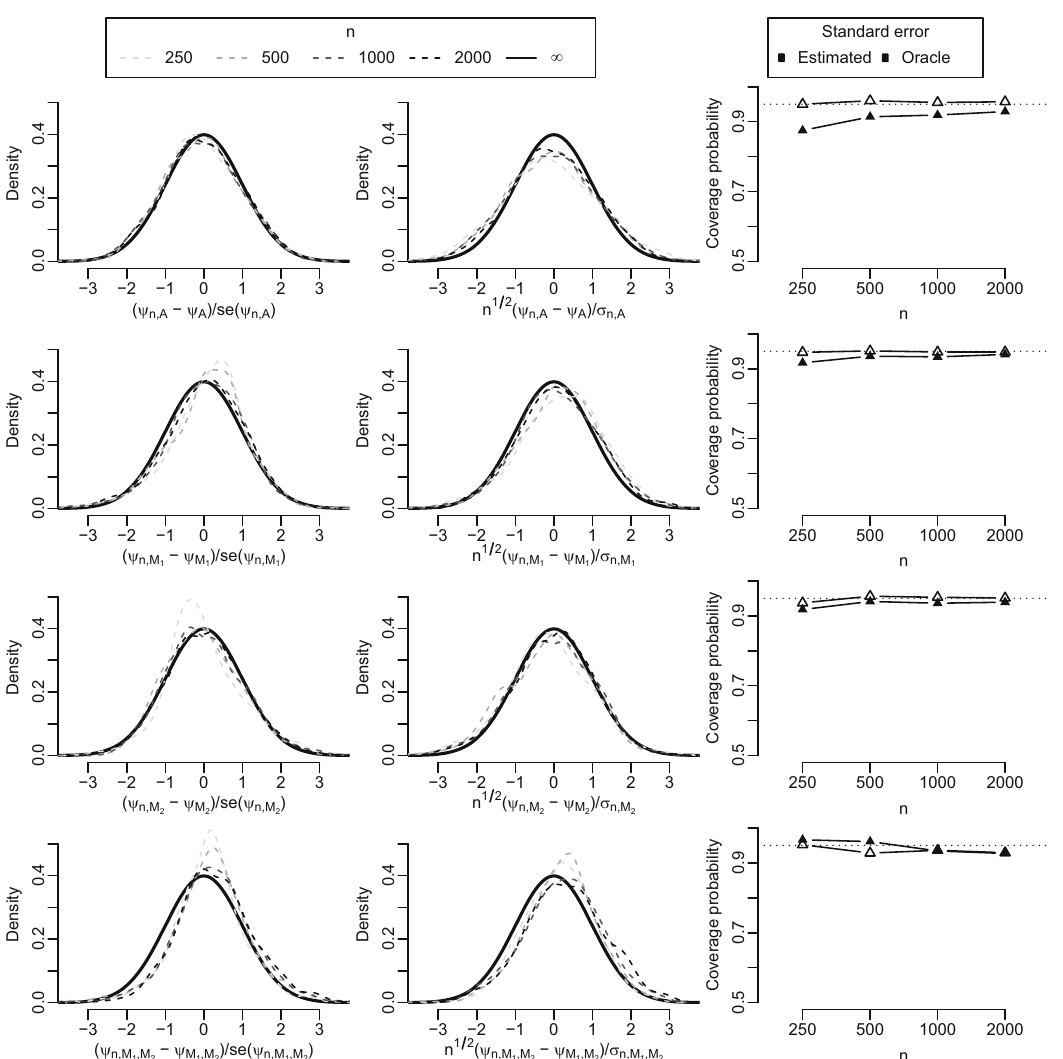
Figure 3: Illustration of weak convergence and Wald - style con fi dence intervals based on the one - step estimator. The left two columns show the kernel density estimate of the sampling distribution of the centered estimates of interventional e ff ects scaled by the oracle standard error ( left ) and by their estimated standard error ( middle ) . In each case, the asymptotic distribution is shown in black. The right panel shows coverage probability of a nominal 95% Wald - style con fi dence interval based on an oracle standard error ( solid triangle ) and an estimated standard error ( open triangle )